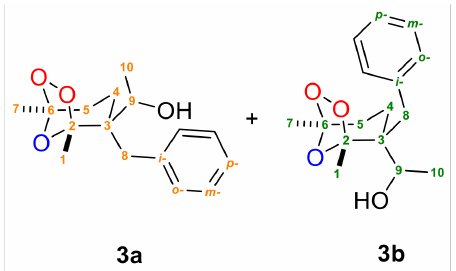
Figure 2. Ozonides 3a + 3b with numbered